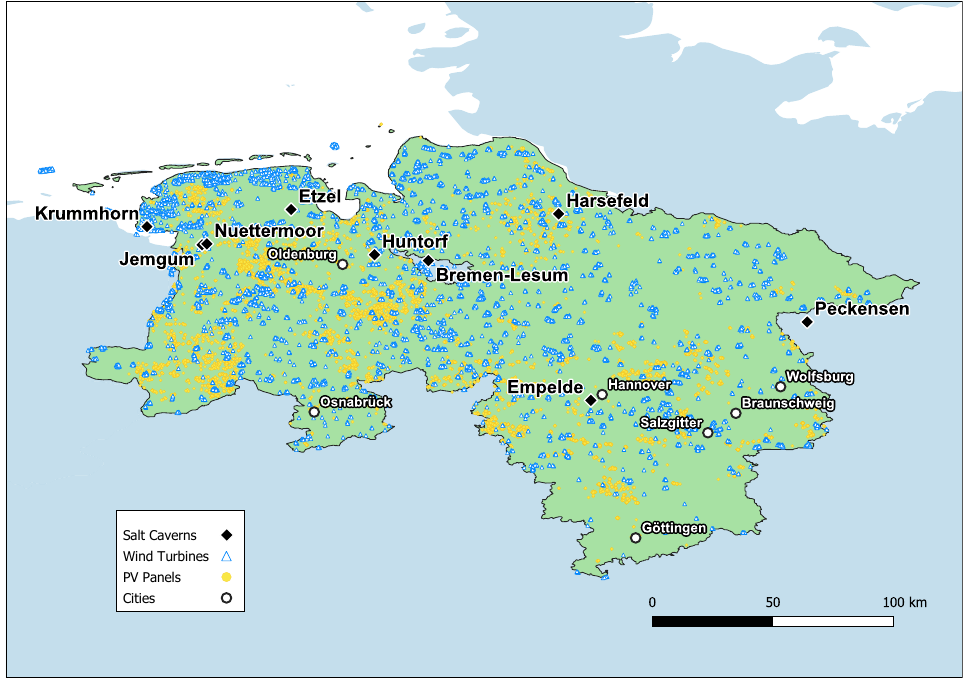
Figure 2. Overview on wind power plants, large photovoltaic (PV) systems and salt cavern gas storage facilities in Lower Saxony. Source: Own representation based on data from